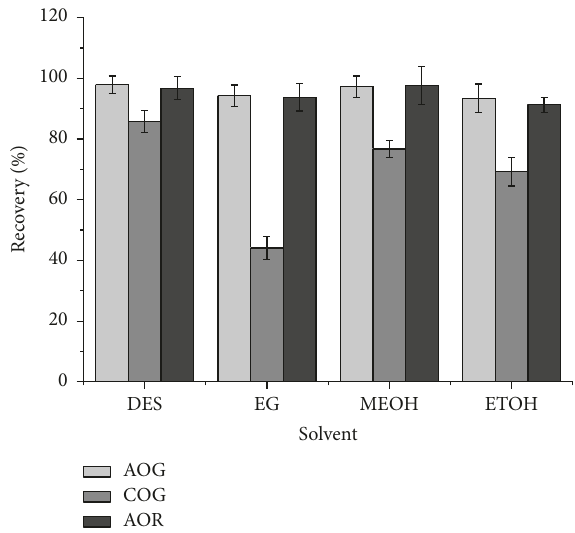
Figure 2: Effects of ChCl/HBD molar ratios on the recoveries of dyes . Sample/liquid: 0.1g/mL, temperature: 30.0 ∘ C, time: 20 min, and ultrasonic power: 75 W.